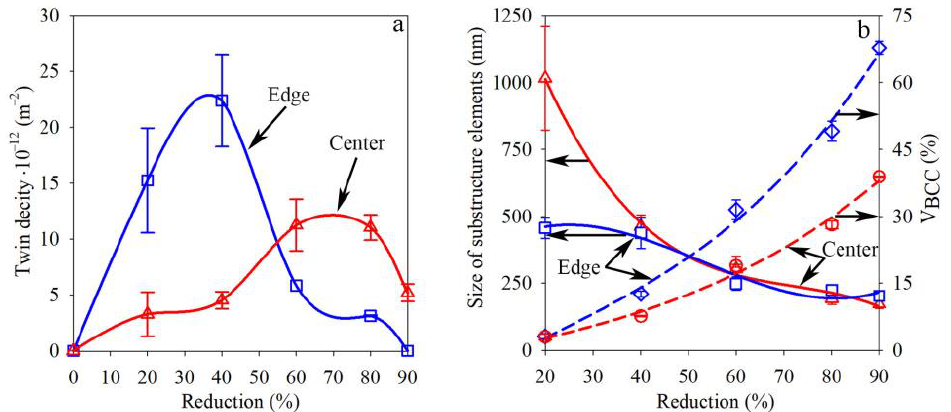
Figure 8. Effect of swaging on ( a ) twin density and ( b ) the average size of the substructure elements and the BCC-phase volume fraction. and the BCC-phase volume